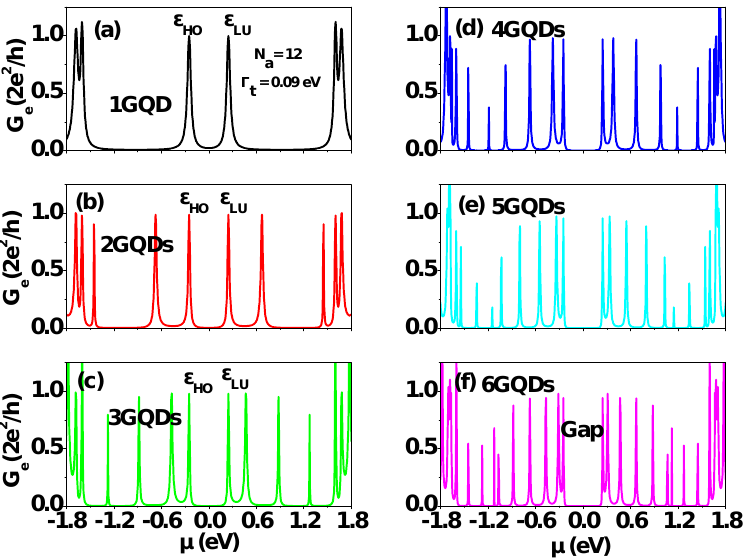
Figure 3. Electrical conductance, G e , as a function of µ for SGQDs with GQD numbers, n = 1,2,3,4,5, and 6 in subfigures ( a ) 1GQD, ( b ) 2GQDs, ( c ) 3GQDs, ( d ) 4GQDs, ( e ) 5GQDs, and ( f ) 6GQDs, respectively. The size of each GQD in these SGQDs is characterized by N a = 12 and N z = 7. Other physical parameters are the same as those used in Figure